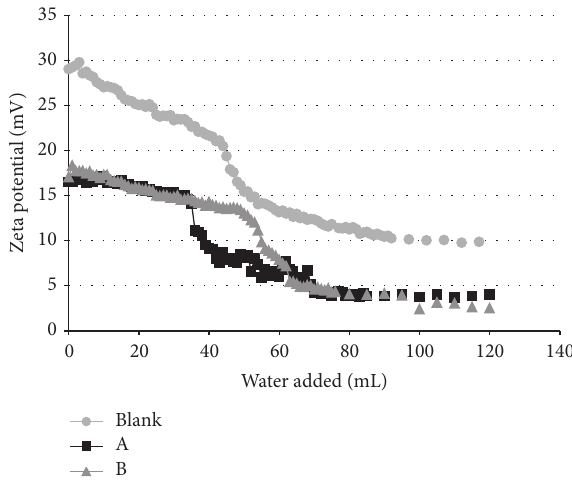
Figure 5: Zeta potential measurements of aqueous limestone sus- pension with and without polymeric inhibitors, A and